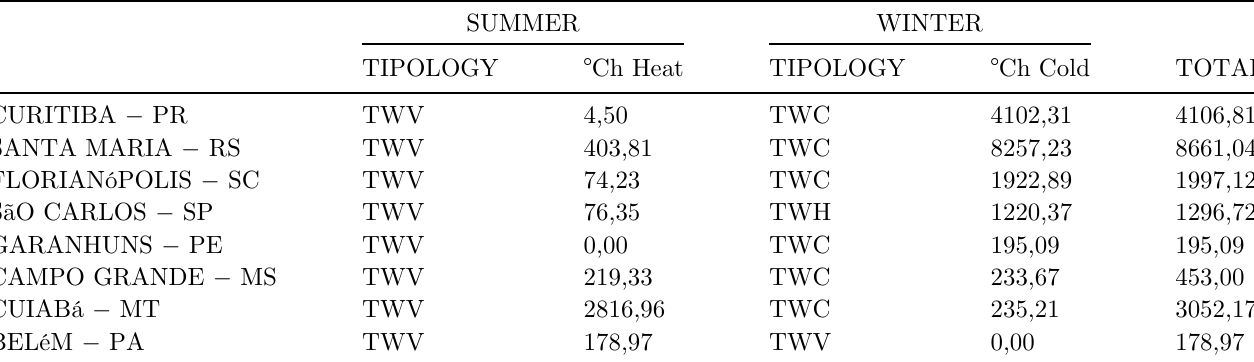
Table 6. Discomfort for the eight cities analyzed, considering the combined use and user intervention.